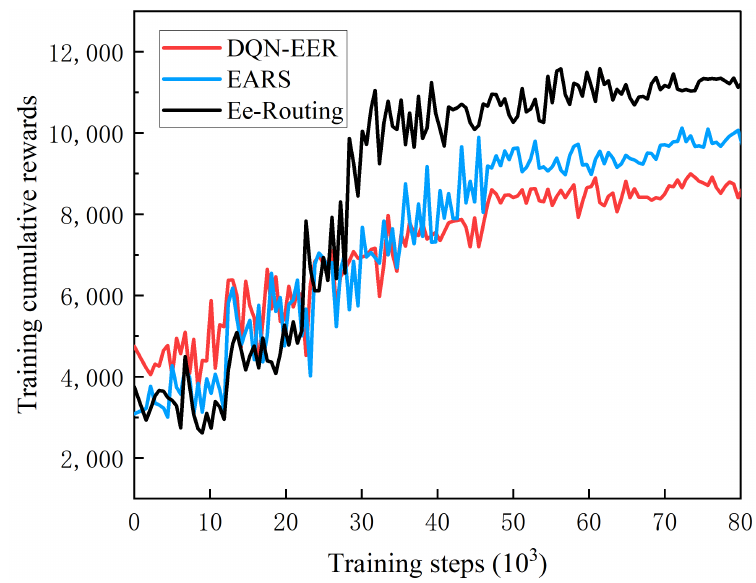
Figure 4. Changes in cumulative